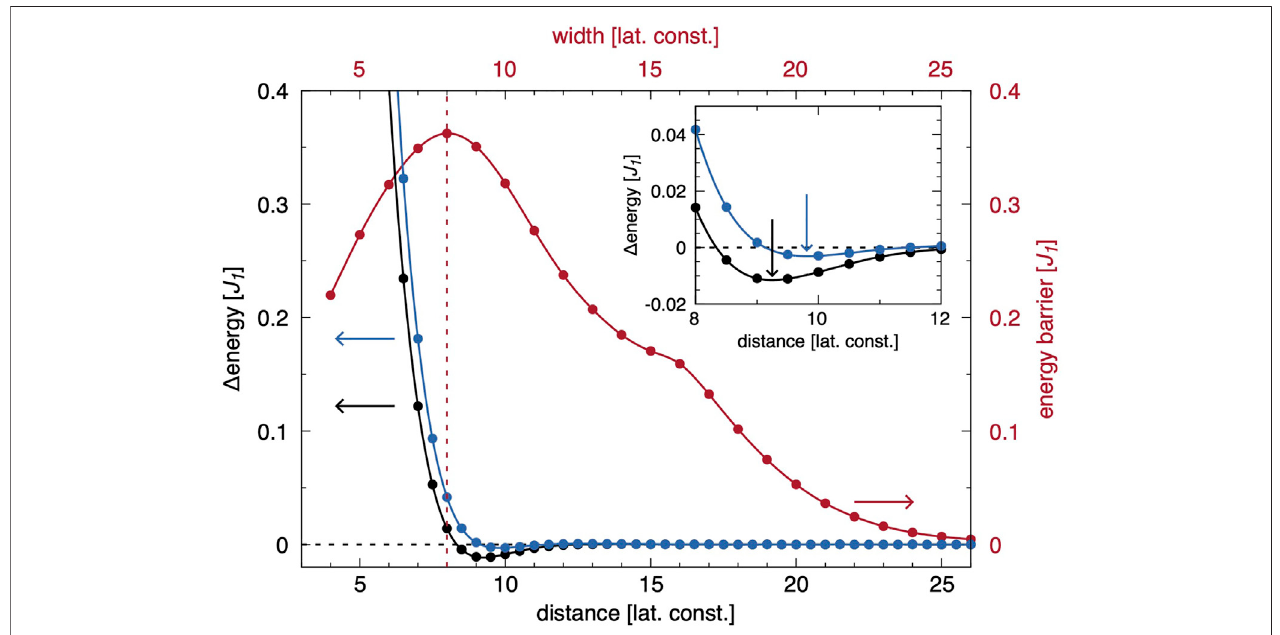
FIGURE4| Energybarriersforapproaching(anti-)skyrmionsonatrackorientedalongthe y -directionofthecrystallatticeandof fi nitewidthin x -direction.Inred,the energy barrier (right axis) for the fusion of a skyrmion and an antiskyrmion in dependence of the width (top axis) of the racetrack is given. The track width for which the energy barrier becomes maximum is highlighted by a red, vertical, dashed line. For this particular width, the distance dependent energy pro fi le (left axis) for a skyrmion and an antiskyrmion located in the middle of the track is shown in blue calculated with the constraint of fi xed chirality, i.e., preventing the local rotation of the atomistic moments within the particles. For two particles of equal type (either skyrmions or antiskyrmions) the pro fi le is shown in black. The reference energy refers to in fi nitely separated particles at the same track width. The inset provides a higher energy resolution in the region around those two minima. The black and blue arrows indicate the distance of minimal